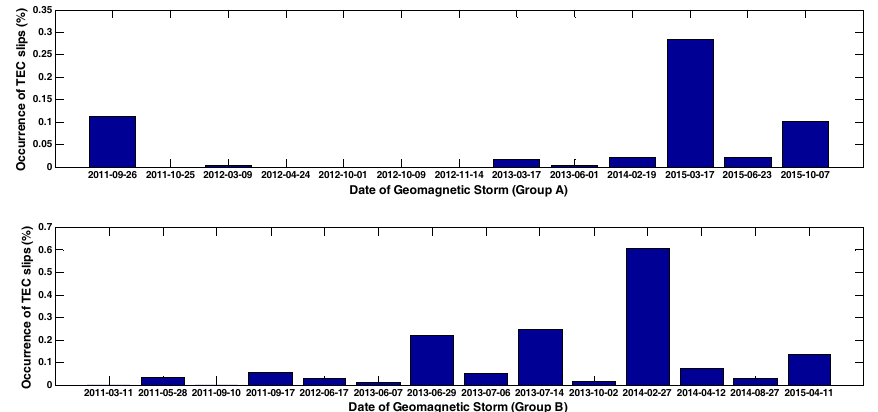
Figure 9. TEC slips towards geomagnetic storm group A geomagnetic storm group B from 2011 to 2015.